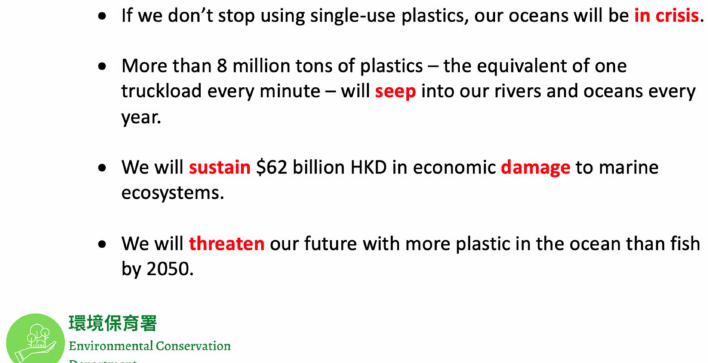
Figure A4. Example of condition 4: loss * text * gov.